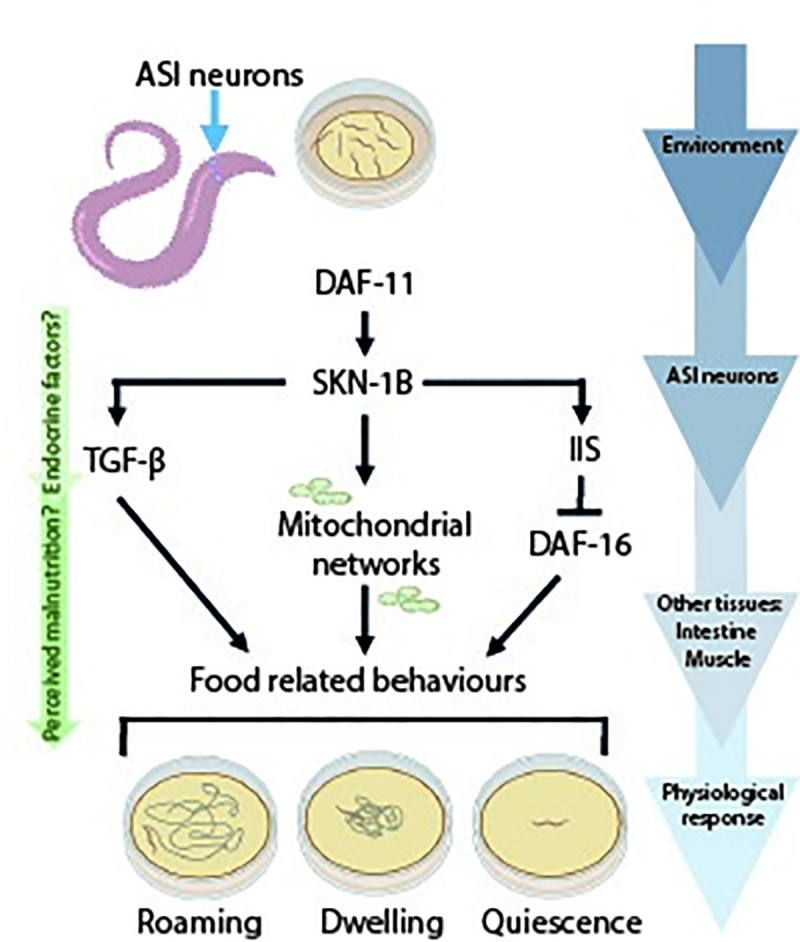
SKN-1B integrates with key nutritional signalling pathways, and regulates mitochondrial networks to control satiety-related behaviour.Food-related behaviour is controlled by interactions between food cues, SKN-1B, downstream signalling pathways (cGMP, TGF-β and IIS), and mitochondria. SKN-1B receives food cues via cGMP signalling (DAF-11). In response to fasting and re-feeding SKN-1B controls satiety quiescence: SKN-1B suppresses daf-7 expression in the ASIs, downregulating TGF-β signalling and suppressing quiescence (Fig 4A–4C). Fasting also induces DAF-16 nuclear localisation which is maintained after re-feeding to promote quiescence: SKN-1B is required for this response, possibly by acting upstream of both pathways (Fig 5A–5E) [6,7]. In parallel, SKN-1B is also acts to control food-related behaviour by maintaining mitochondrial networks. Overall, this study identifies neuronal SKN-1B as a novel factor in controlling satiety behaviour in response to dietary signals.